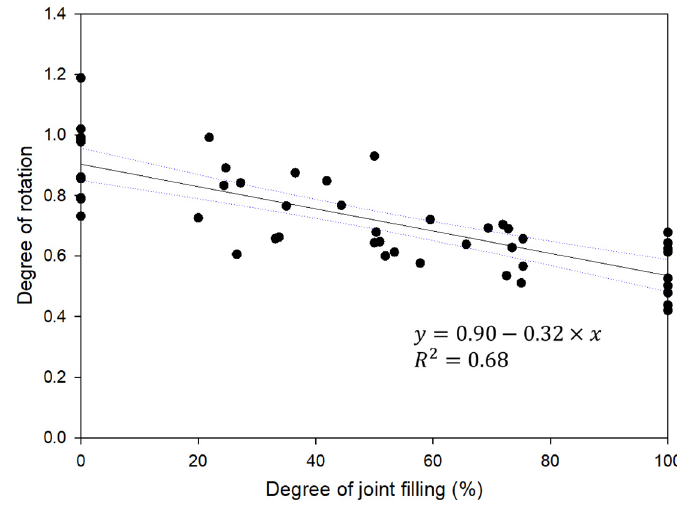
Figure 12. Rotational angles according to degree of joint filling.